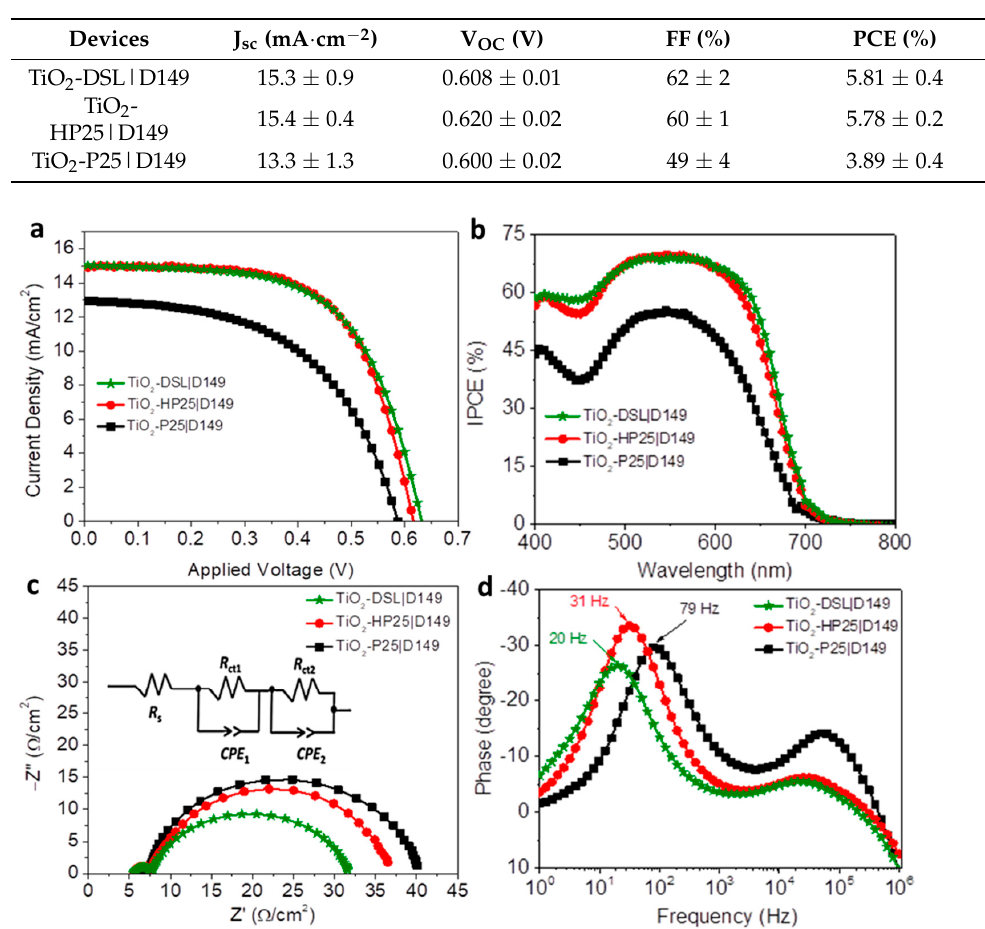
Figure 2. ( a ) Photocurrent-voltage (J-V) characterizations, ( b ) IPCE measurements, ( c , d ) EIS measurements, and Nyquist and Bode plots of TiO 2 -DSL|D149, TiO 2 -HP25|D149, and TiO 2 -P25|D149 devices.